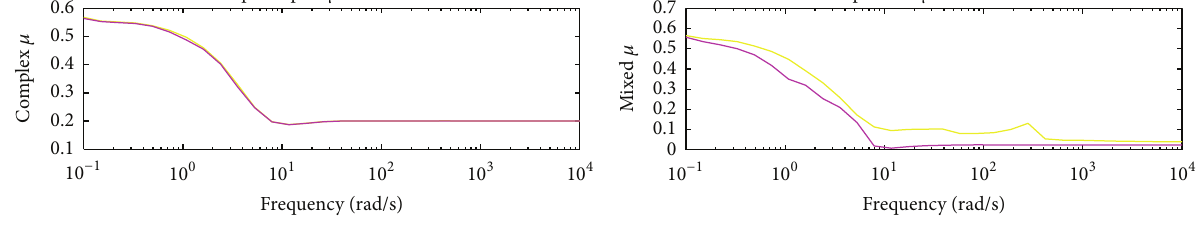
Figure 13: 𝜇 plot after third iteration.